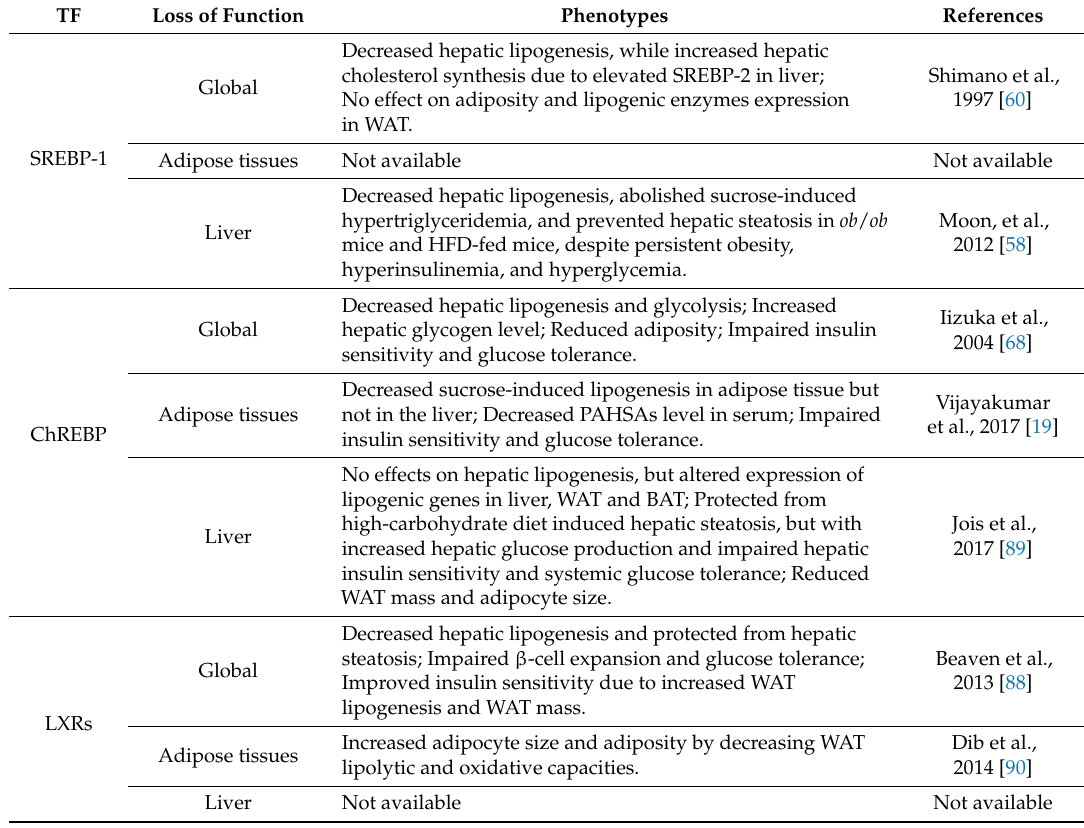
Table 1. Summary of loss-of-function studies for major lipogenic transcription